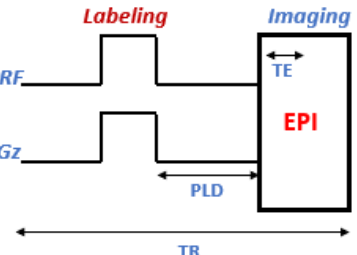
Figure 2. Schematic representation of the CASL sequence. EPI: echo planar imaging module; TE: echo time; PLD: post labeling delay; TR: repetition time; G z : gradient.